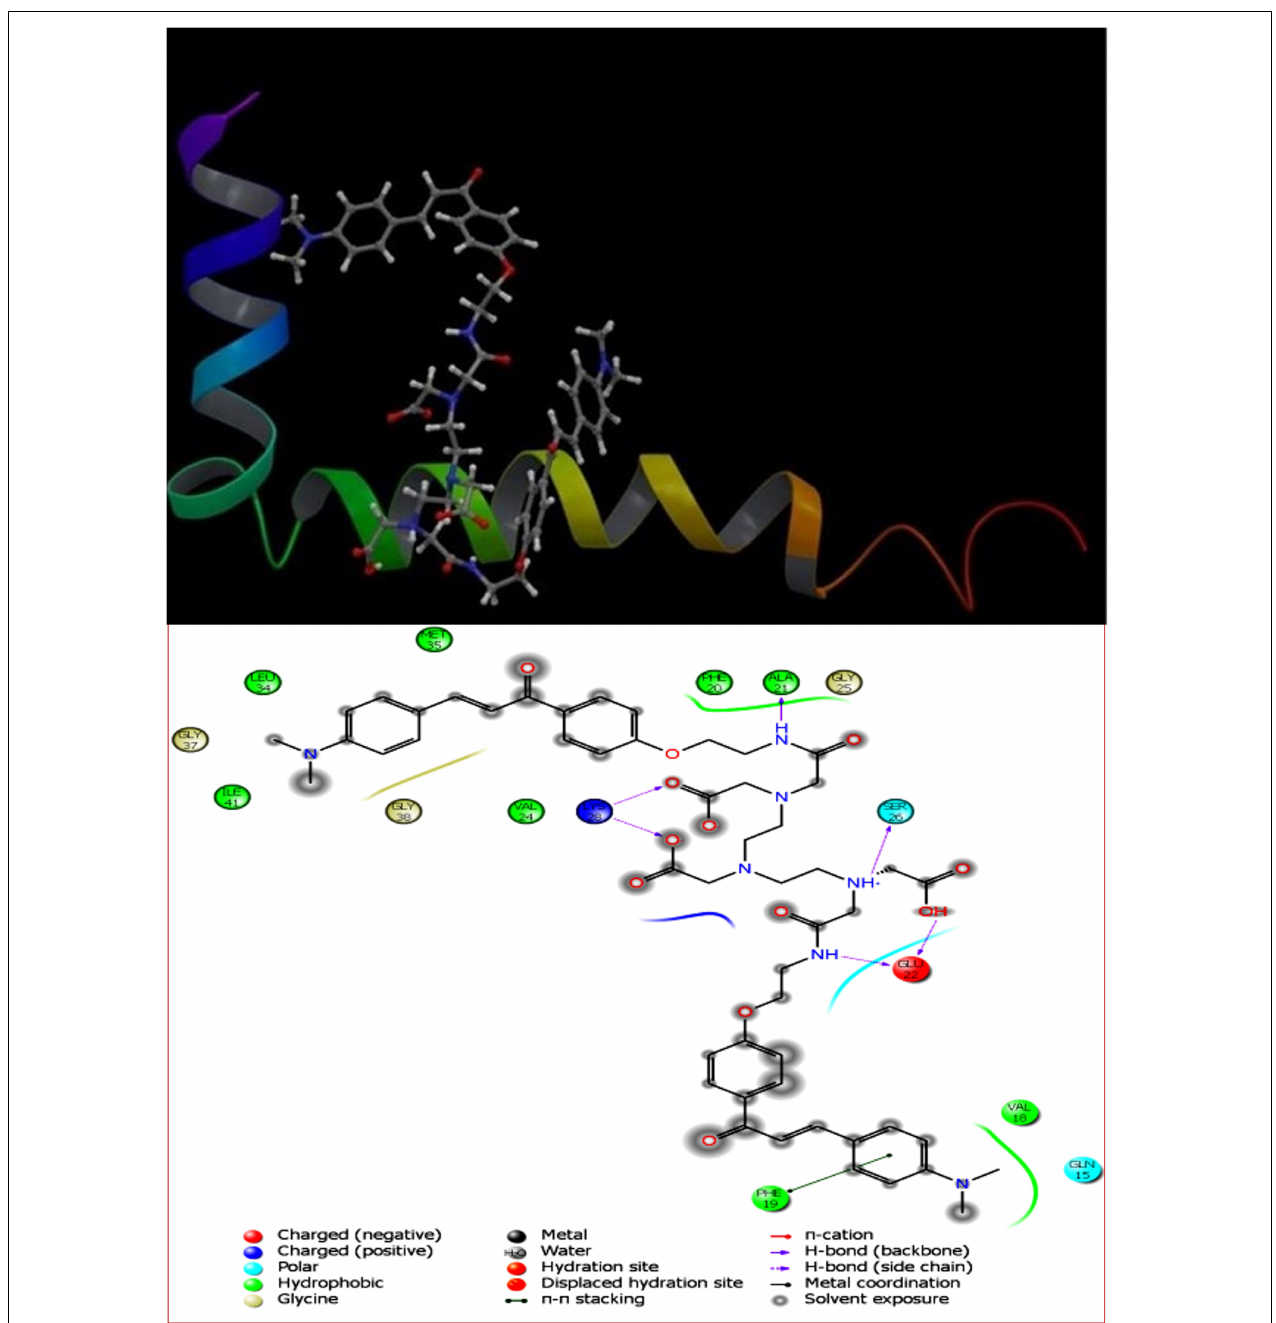
FIGURE 4 | DT(Ch) 2 3D docking pose depicting the 2D and binding view of amyloid-beta monomer (1IYT).